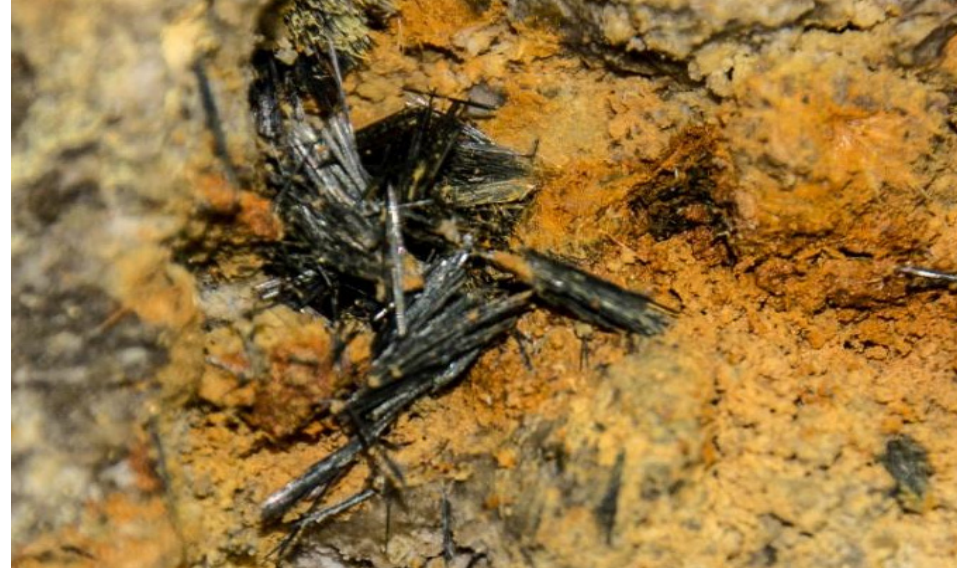
Figure 3. Antimonite mineralization of the Libanka mining district (photo by Silvia